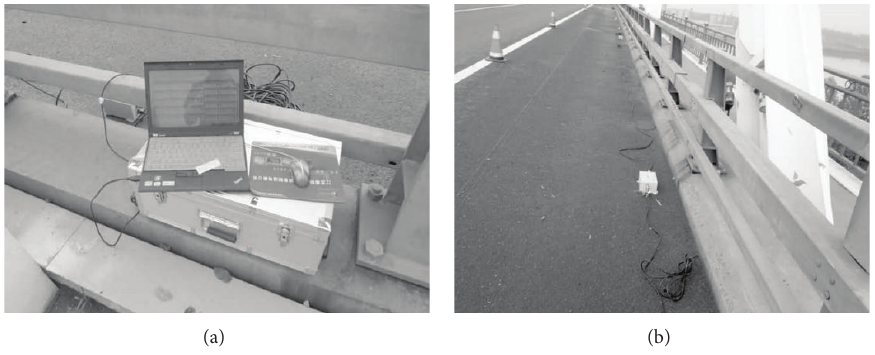
Figure 8: Ambient vibration testing of Guanhe Bridge.